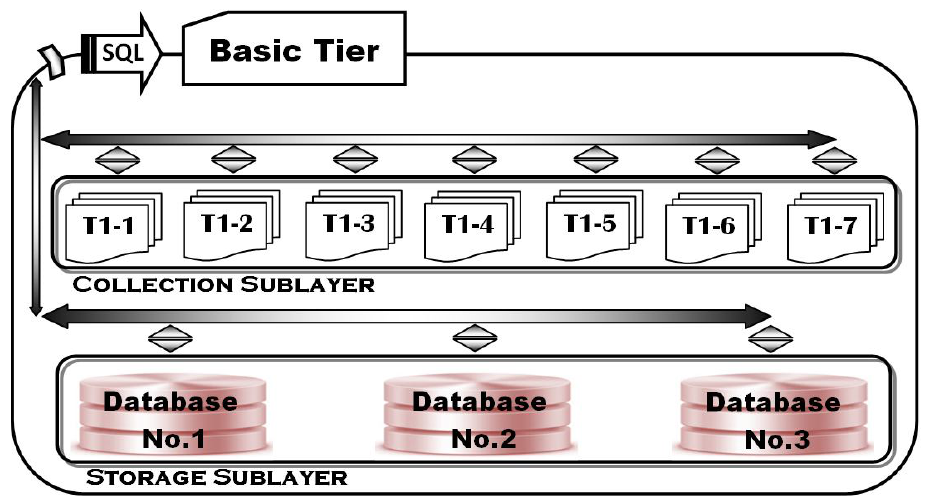
Fig. 2. Details of operational processes and acting elements in Basic Tier of